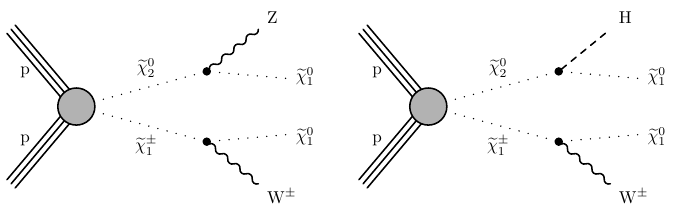
Figure 2 . Chargino and neutralino pair production with the chargino decaying to a W boson and the LSP and the neutralino decaying to (left) a Z boson and the LSP or (right) a Higgs boson and the LSP.